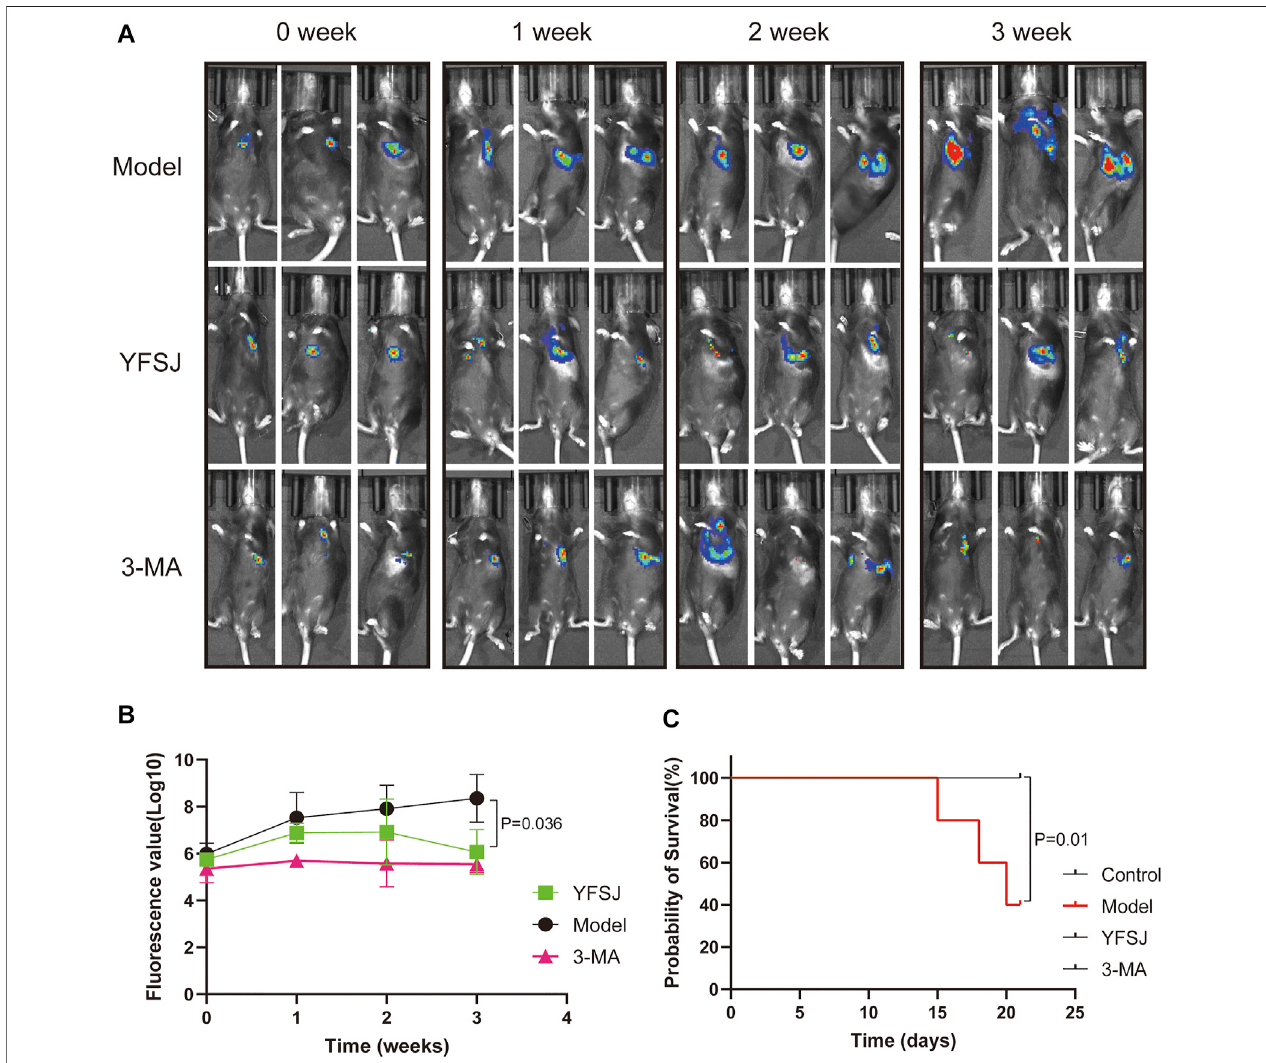
FIGURE 2 | Fluorescence photography of mice in each group at 0, 1, 2, and 3 weeks of administration (A) . Tumor fl uorescence value in each group (B) ; survival time of mice in each group ( n = 5) (C) . Model: Model group; YFSJ: Yi-Fei-San-Jie pill group; 3-MA: autophagy inhibitor 3-MA group.